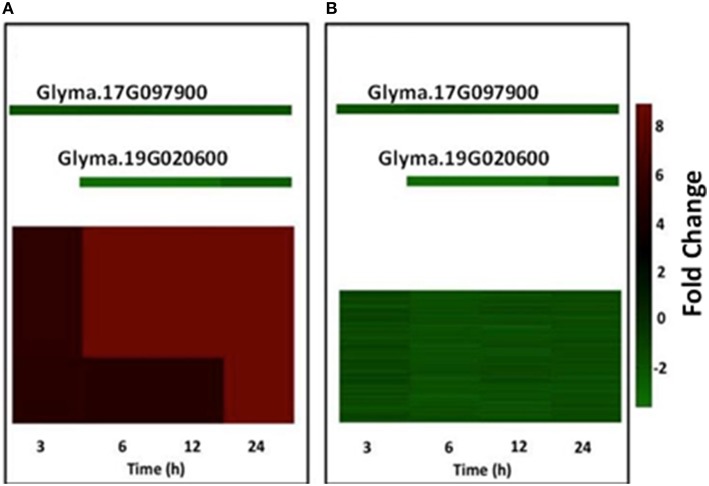
Gene regulatory modules controlling the transcriptional responses of soybean root hairs to heat stress. Panels (A,B) show two significant modules controlled by two different TFs. Individual genes are represented by small squares. Transcript abundance values were false color-coded by using a scale of −2 to ±8. The intensity of green and red colors indicates the degree of expression of the corresponding genes. Data are the average of two biological replicates.